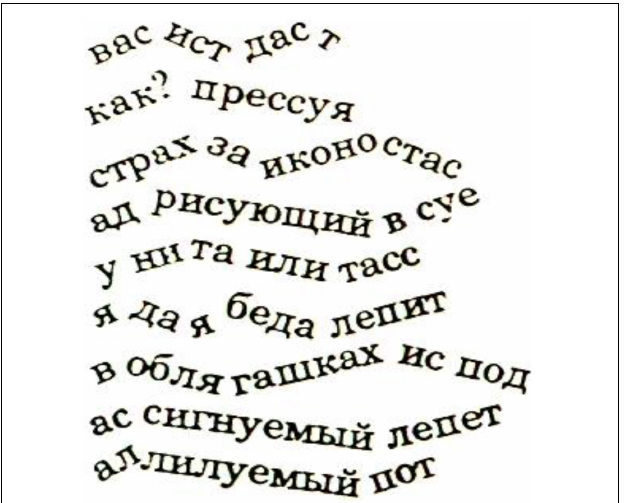
FIGURE 1 | Gornon’s